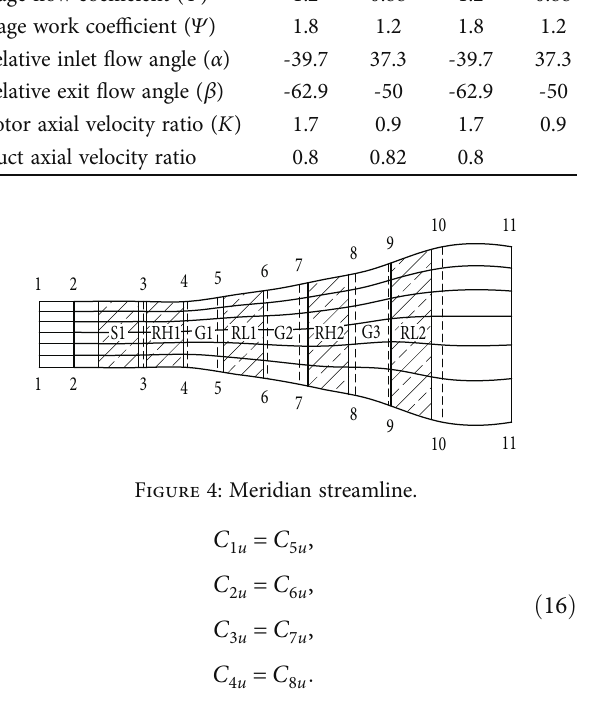
Figure 4: Meridian